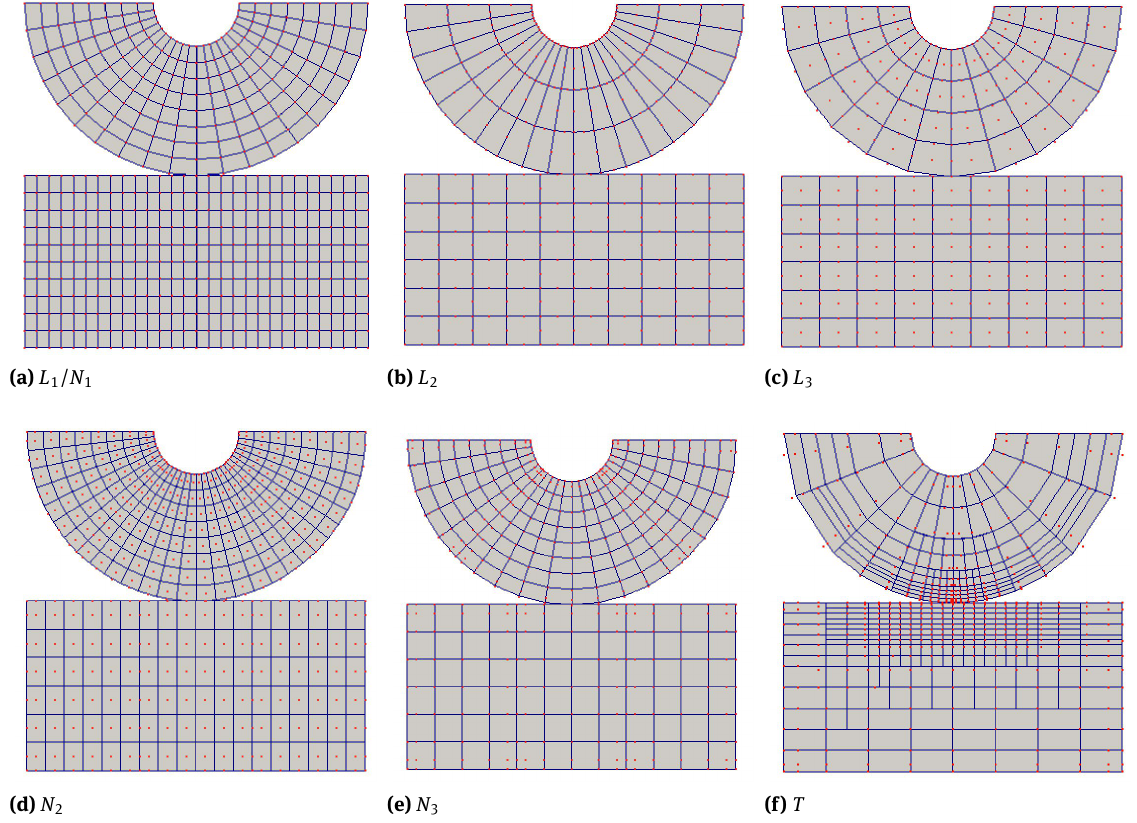
Figure 8: Ironing problem: Lagrange, NURBS, and T-spline meshes. Dof = 1044 .